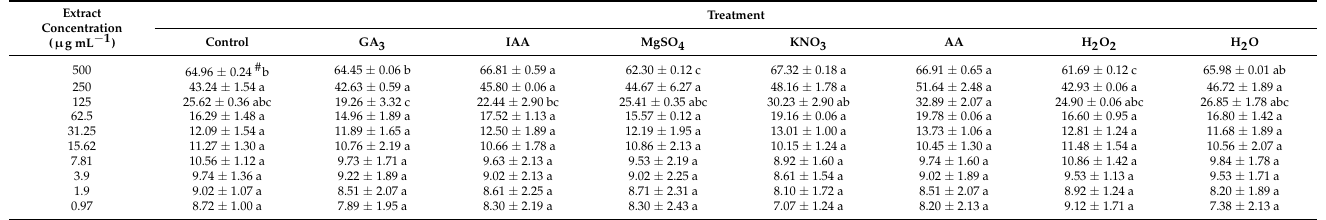
Table 4. Influence of different priming treatments on percentage of DPPH inhibition in the above- ground parts of radish ( R. sativus )